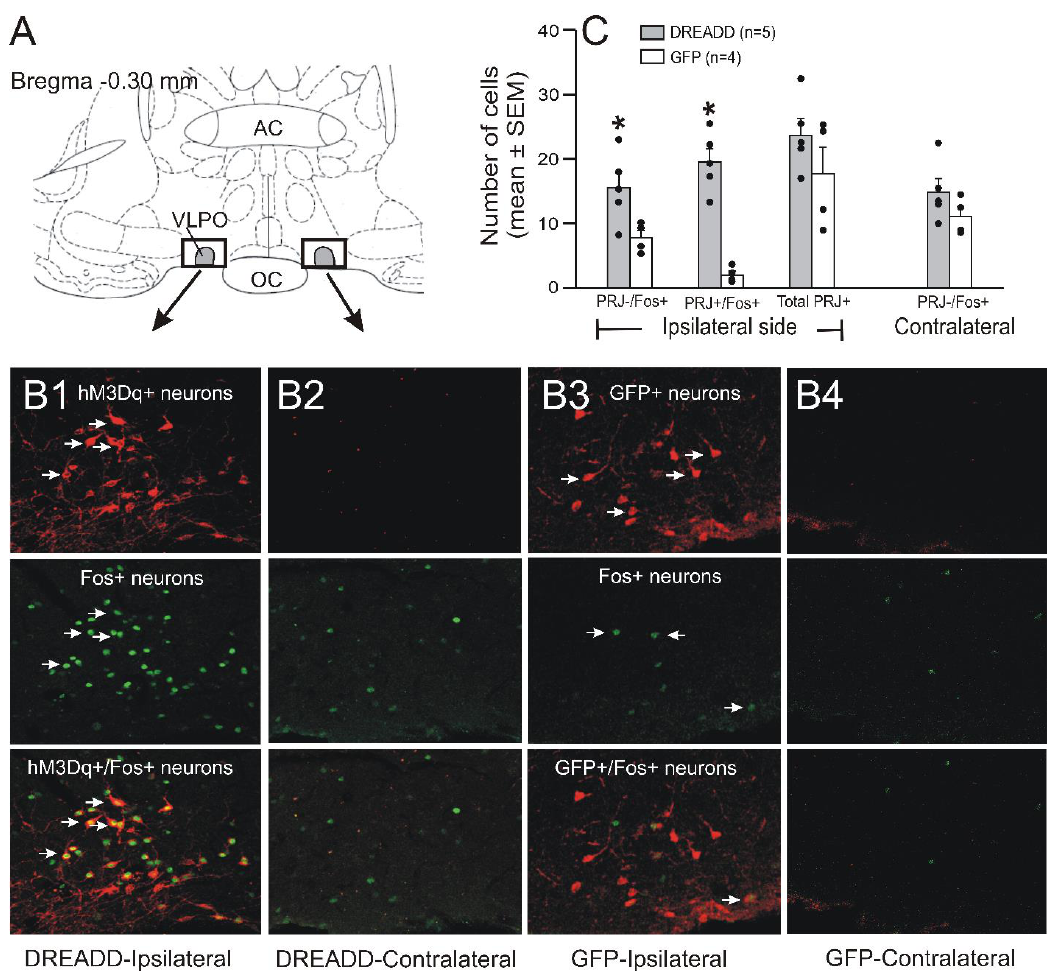
Figure 6. CNO activated VLPO > PF- HA PRJ neurons expressing hM3Dq . ( A ): schematic represen- tation of the target site and where most of the VLPO > PF-HA PRJ neurons expressing hM3Dq or GFP were localized. ( B1 – B4 ): photomicrographs of representative ipsilateral and contralateral histologi- cal sections showing Fos-IR in VLPO > PF-HA PRJ neurons (marked by arrows) expressing hM3Dq (mCherry; ( B1 , B2 )) or GFP (dTomato; ( B3 , B4 )) after 1 mg/kg of CNO injection during the dark phase. In all figures, both mCherry and GFP are represented in red, for convenience, and c-fos in green (the original staining of Fos-IR was in far-red). ( C ): The number of VLPO > PF-HA PRJ and VLPO > PF-HA non-PRJ neurons expressing Fos-IR in individual rats (filled circles) and as a group (mean ± SEM; bars) after CNO treatment in the DREADD and non-DREADD rats. While the number of VLPO > PF-HA PRJ neurons expressing hM3Dq or GFP was comparable, CNO significantly in- creased Fos-IR in VLPO > PF-HA PRJ neurons expressing hM3Dq. Arrow; cell type; AC, anterior com- missure; OC, optic chiasm; PRJ − , VLPO > PF-HA non-PRJ neurons; PRJ+, VLPO > PF-HA PRJ neurons; PRJ+/Fos+, VLPO > PF-HA PRJ neurons expressing Fos-IR; PRJ − /Fos+, VLPO > PF-HA non-PRJ neurons expressing Fos-IR; VLPO, ventrolateral preoptic area. * p < 0.05 level of significance (Mann – Whitney rank sum test).